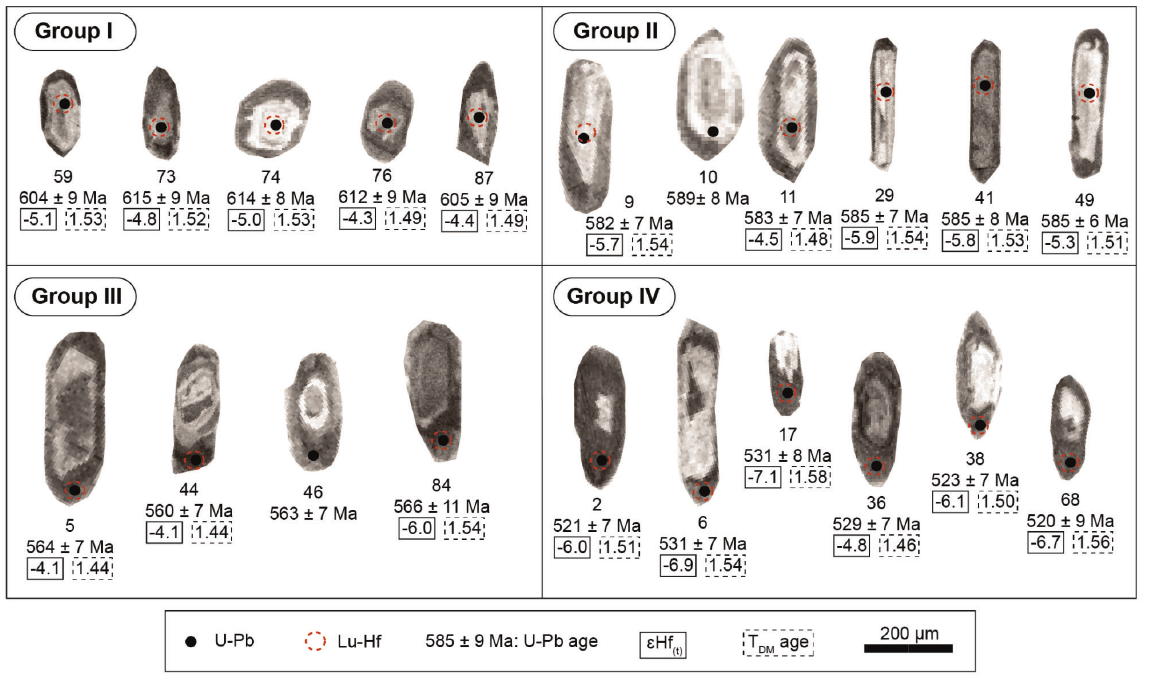
Figure 11. Representative cathodoluminescence (CL) images showing LA-ICP-MS spots for Hf isotopes. U-Pb error reported as